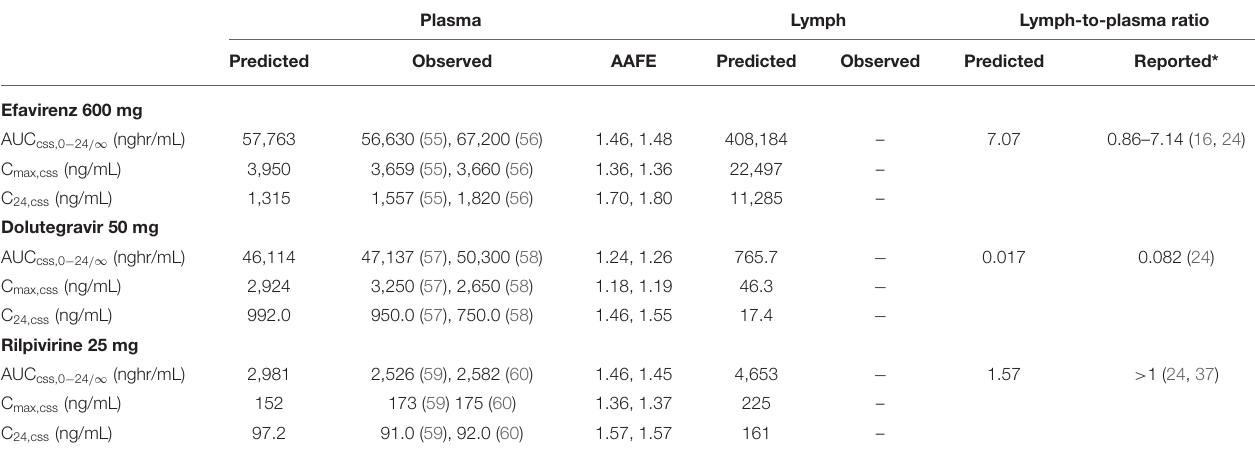
TABLE 3 | Median Plasma and Lymph pharmacokinetic parameters for efavirenz, dolutegravir, and rilpivirine in non-pregnant adult. Plasma Lymph Lymph-to-plasma ratio Predicted Observed AAFE Predicted Observed Predicted Reported*